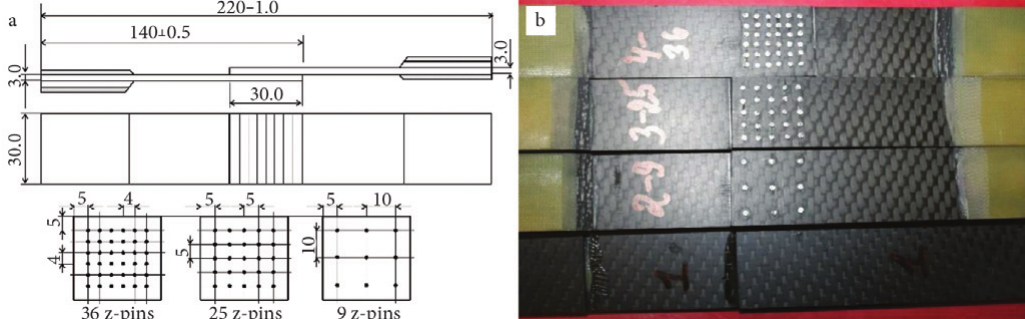
Fig. 4. Tested joints: a – geometry and distribution of the z-pins (dimensions are in mm); b – view on the